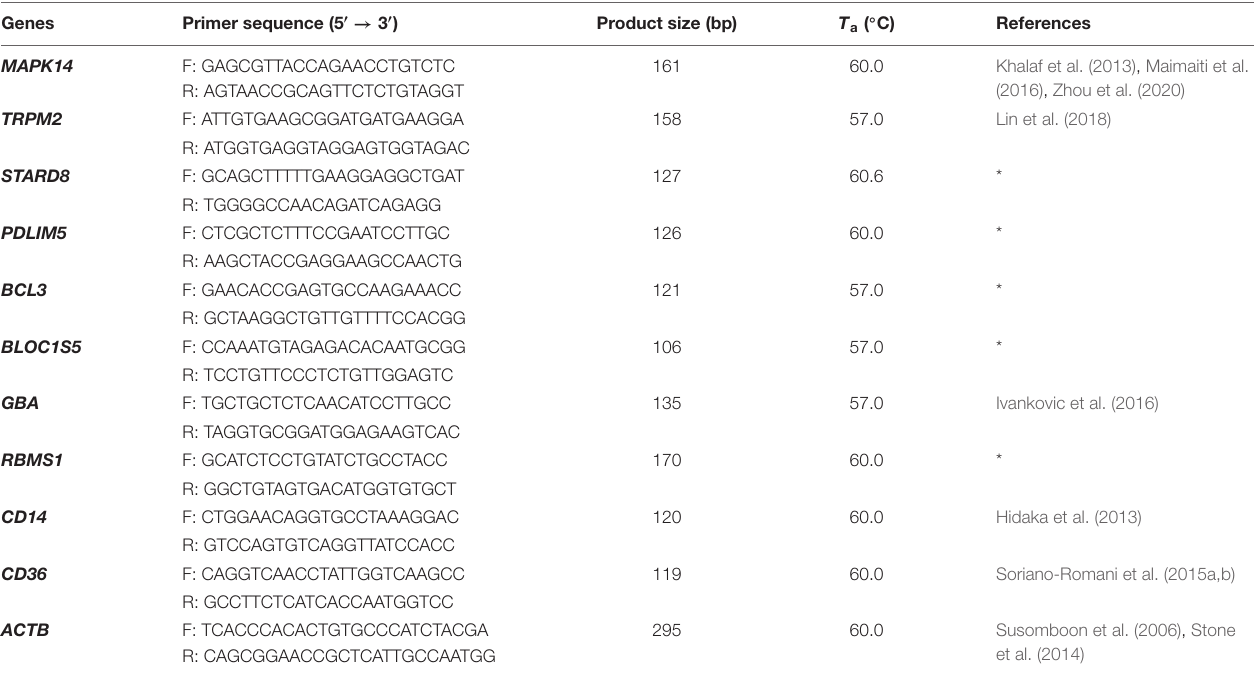
TABLE 2 | Primers for gene amplification in quantitative real-time